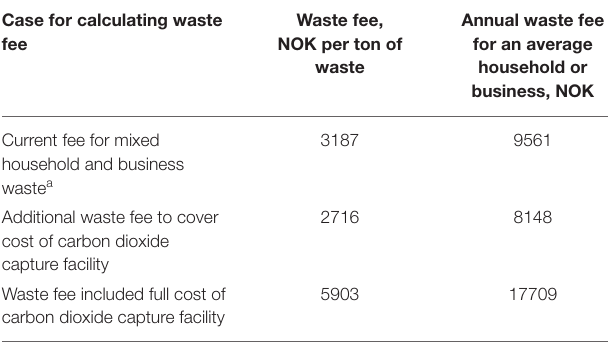
TABLE 1 | Cost of full-scale carbon dioxide capture at the Fortum Oslo Varme waste-to-energy